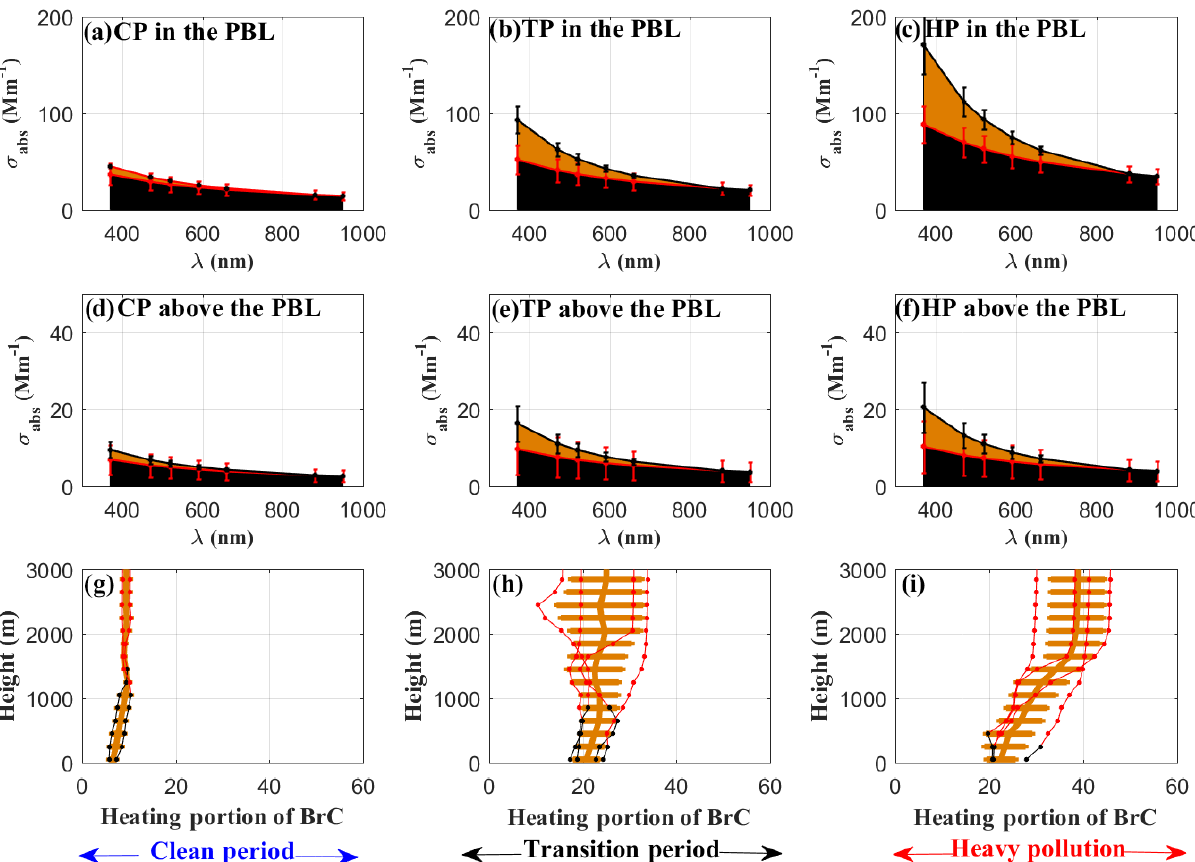
Figure 8. Spectral absorption coefficient of BC and BrC inside of and above the PBL for CP (a, d) , TP (b, e) and HP (c, f) , respectively, shown in black and brown for BC and BrC, respectively. The vertical profiles of heating portion of BrC for CP, TP and HP are shown in (g) – (i)